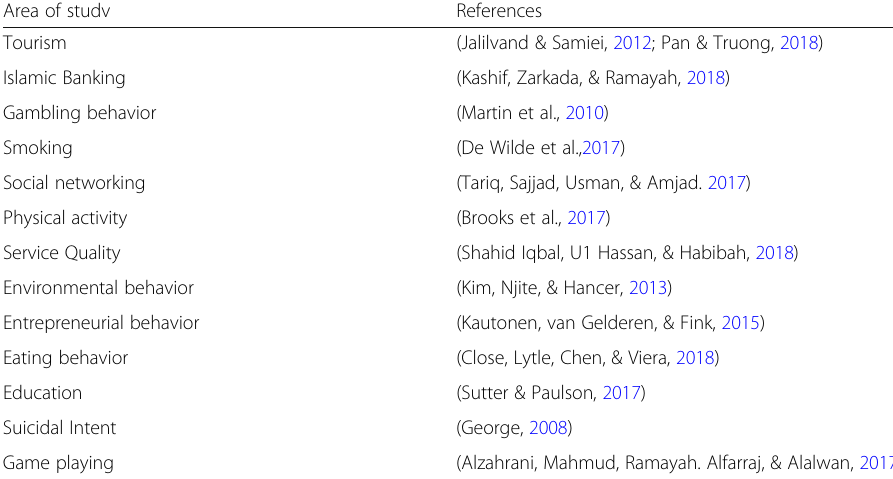
Table 1 Recent Literature summary of TPB applicability Area of